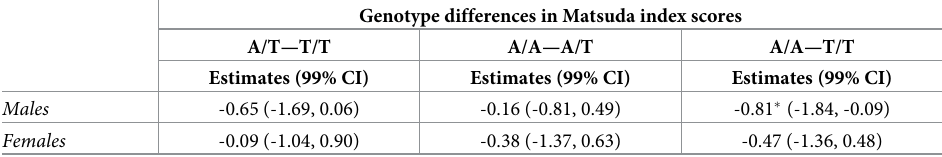
Table 3. Genotype differences in total insulin sensitivity (Matsuda index) derived from the meal test for males and females as estimated by the RLM analysis.